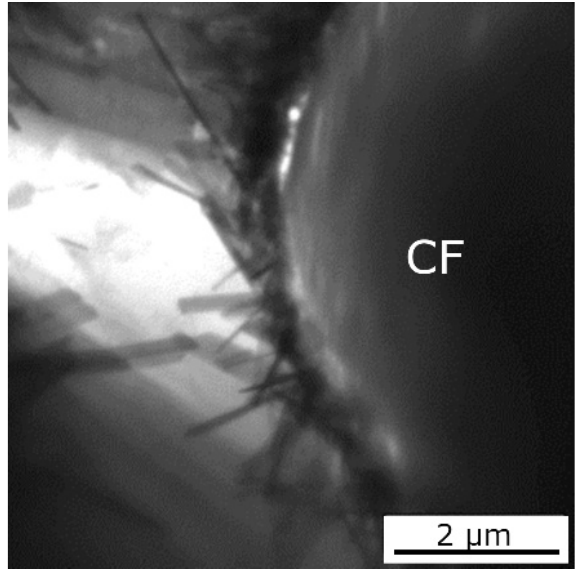
Figure 9. TEM image of the MgY/Granoc interface.